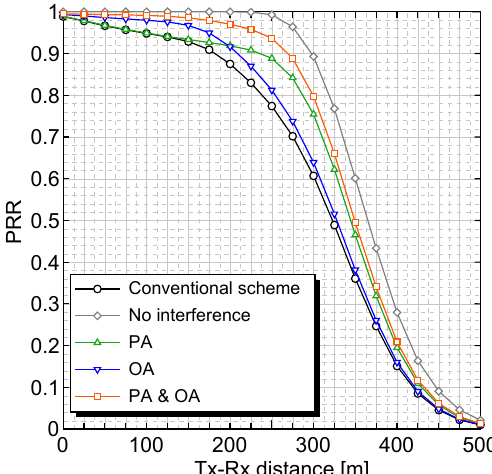
Figure 11. Effect of the PRR for generation pattern